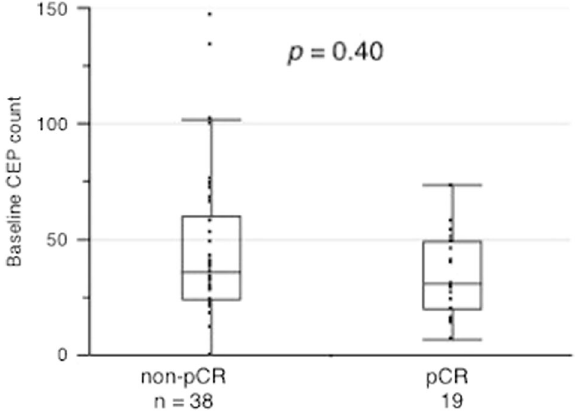
Fig. 1 Comparison of baseline CEP counts between non-pCR and pCR groups. The y-axis indicates the baseline CEP count. There was no signi fi cant difference in CEP counts between the non-pCR and pCR groups ( p = 0.40, Mann — Whitney test : two-sided)